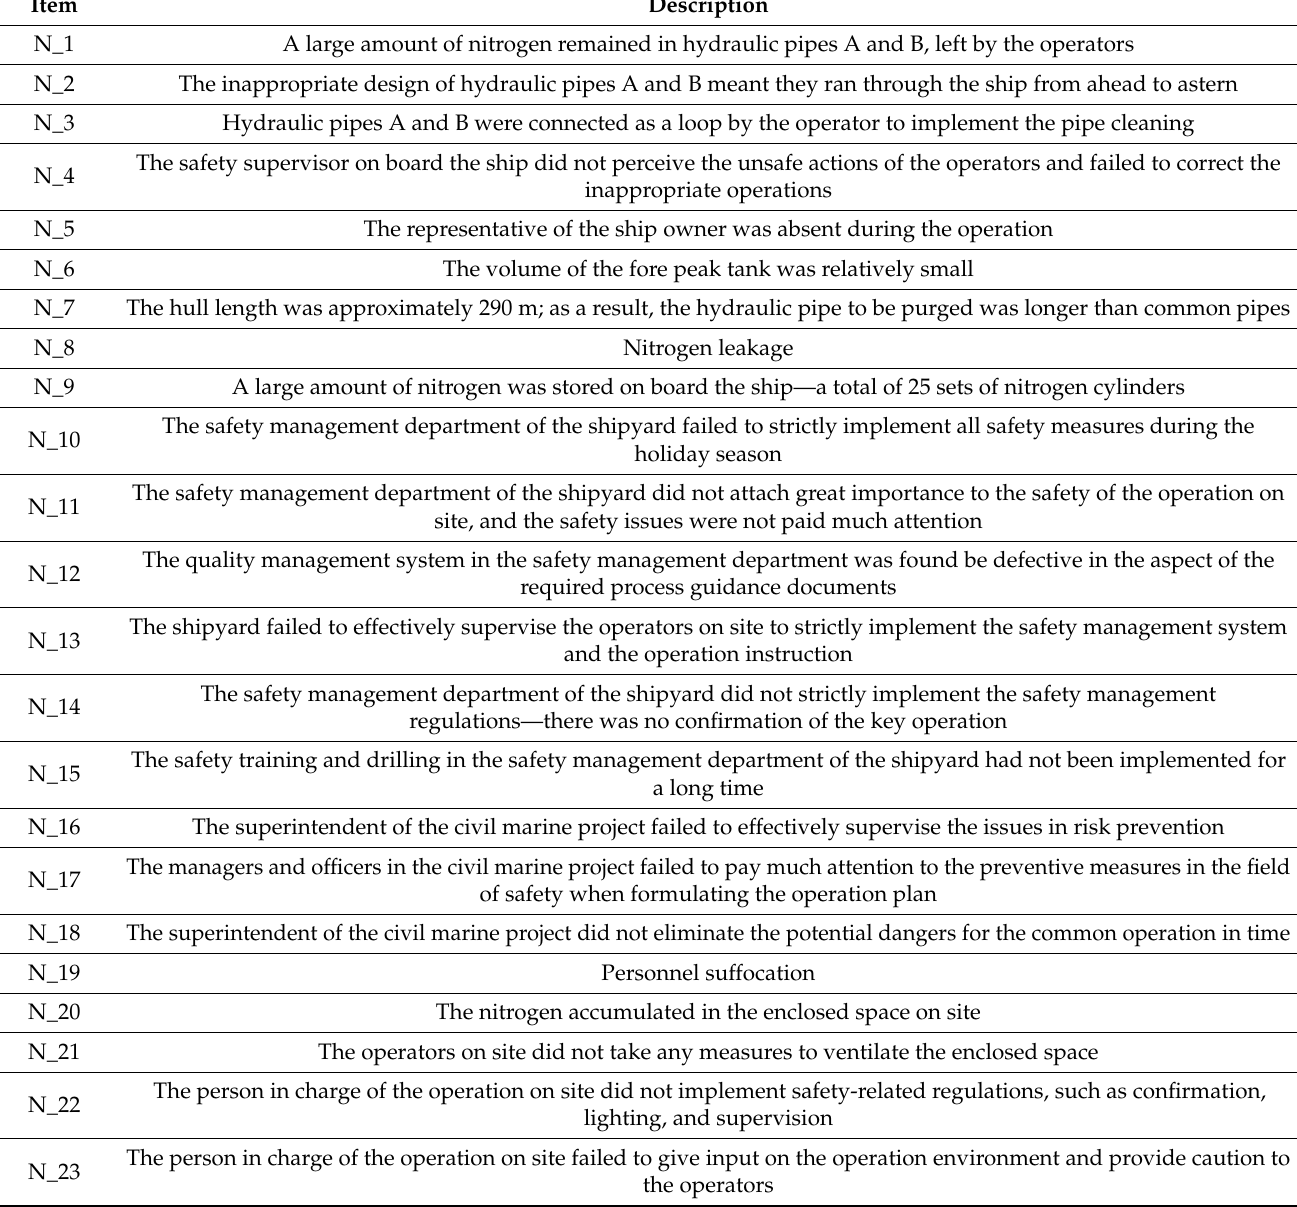
Table 2. Hazardous events identified from the accident